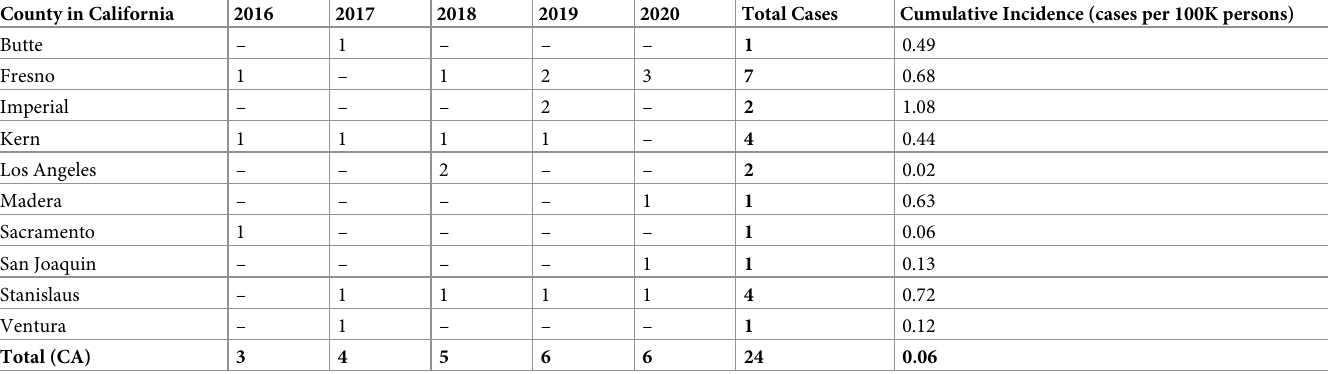
Table 3. Number of human St. Louis encephalitis virus (SLEV) cases and cumulative incidence of SLEV disease cases by year, California, 2016–2020.–Indicates no detections. County in